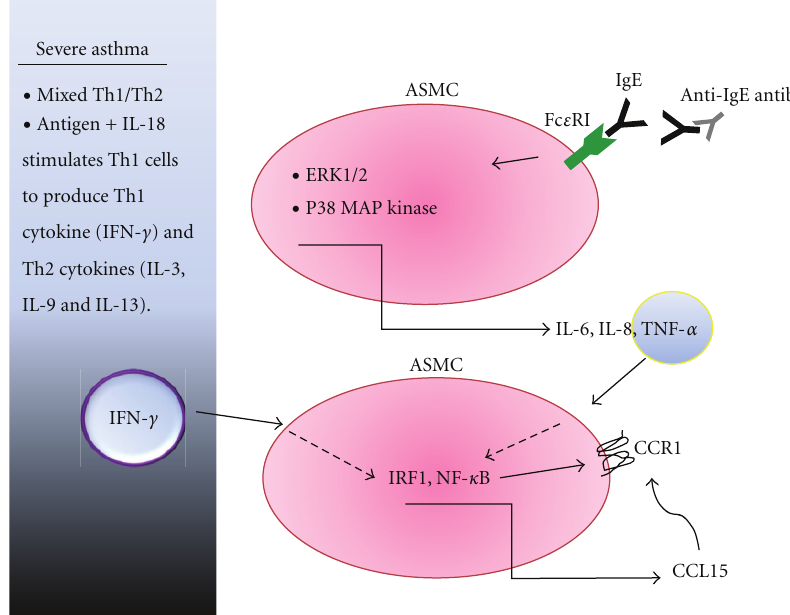
Figure 1: CCL15/CCR1-mediated inflammatory response associated with IgE in ASMCs from an asthma patient. IgE-stimulated ASMC produce IL-6, IL-8, and TNF- α via the activation of extracellularly regulated MAP kinase-1/2 (ERK1/2) and p38 MAP kinase. TNF- α also plays a role in CCL15 production by synergistically enhancing the e ff ect of IFN- γ via interferon regulatory factor-1 (IRF-1) and NF- κ B. IFN- γ production is abundant in patients with mixed Th1/Th2 or Th1 asthma. TNF- α and IFN- γ upregulate CCR1 expression by ASMC, while binding of CCL15 to CCR1 might influence the severity and persistence of